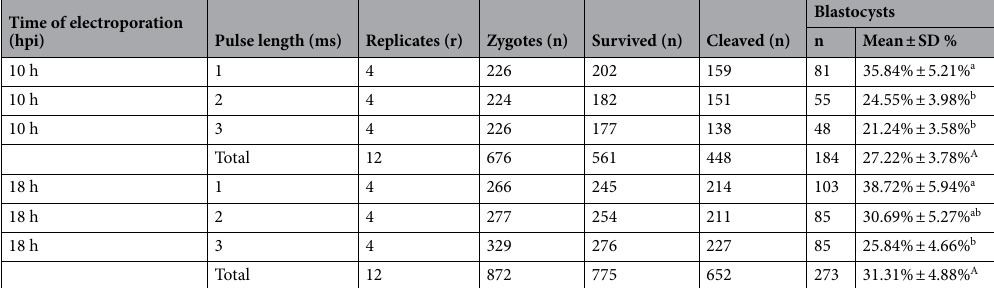
Table 1. Effect of time post insemination and pulse length on embryo developmental metrics. Zygotes were electroporated after 10 or 18 h using 5 pulses of 1, 2 or 3 ms at 25 V. Lowercase letters denote significant differences between pulse lengths (p < 0.05) within voltage groups. Uppercase letters denote significant differences within HPI groups. Hpi hours post insemination. a,b,c p < 0.05, A,B p <